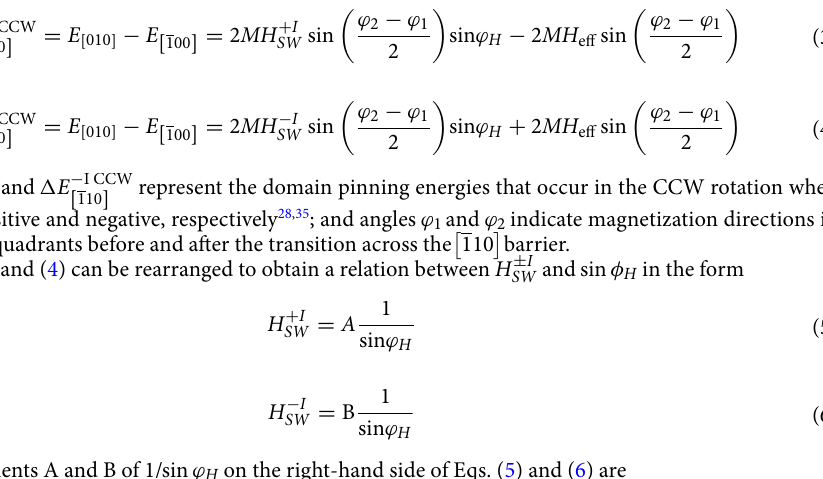
where the coefficients A and B of 1/ sin ϕ H on the right-hand side of Eqs. (5) and (6) are